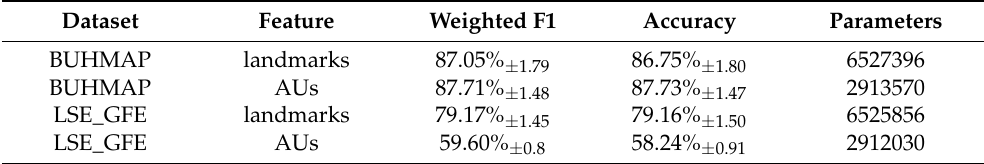
Table 6. Performance of baseline MSG3D model.